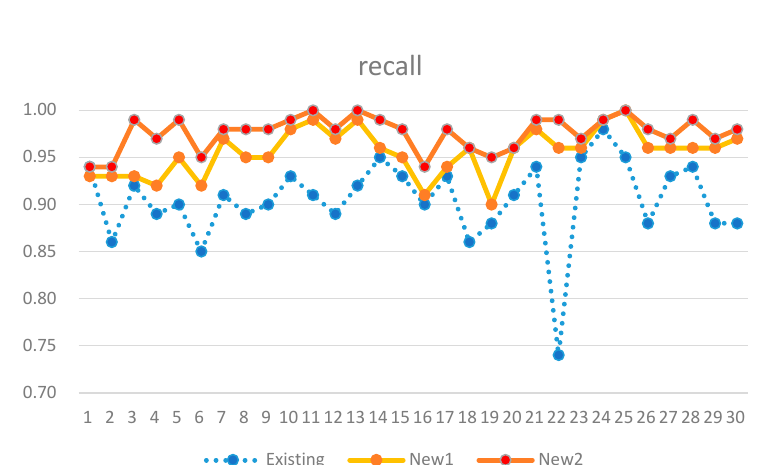
Figure 16. Performance comparison in recall metric.